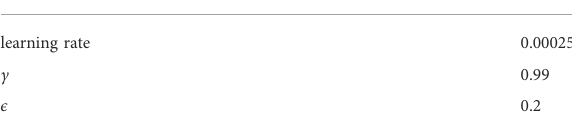
TABLE 3 Hyperparameters used for